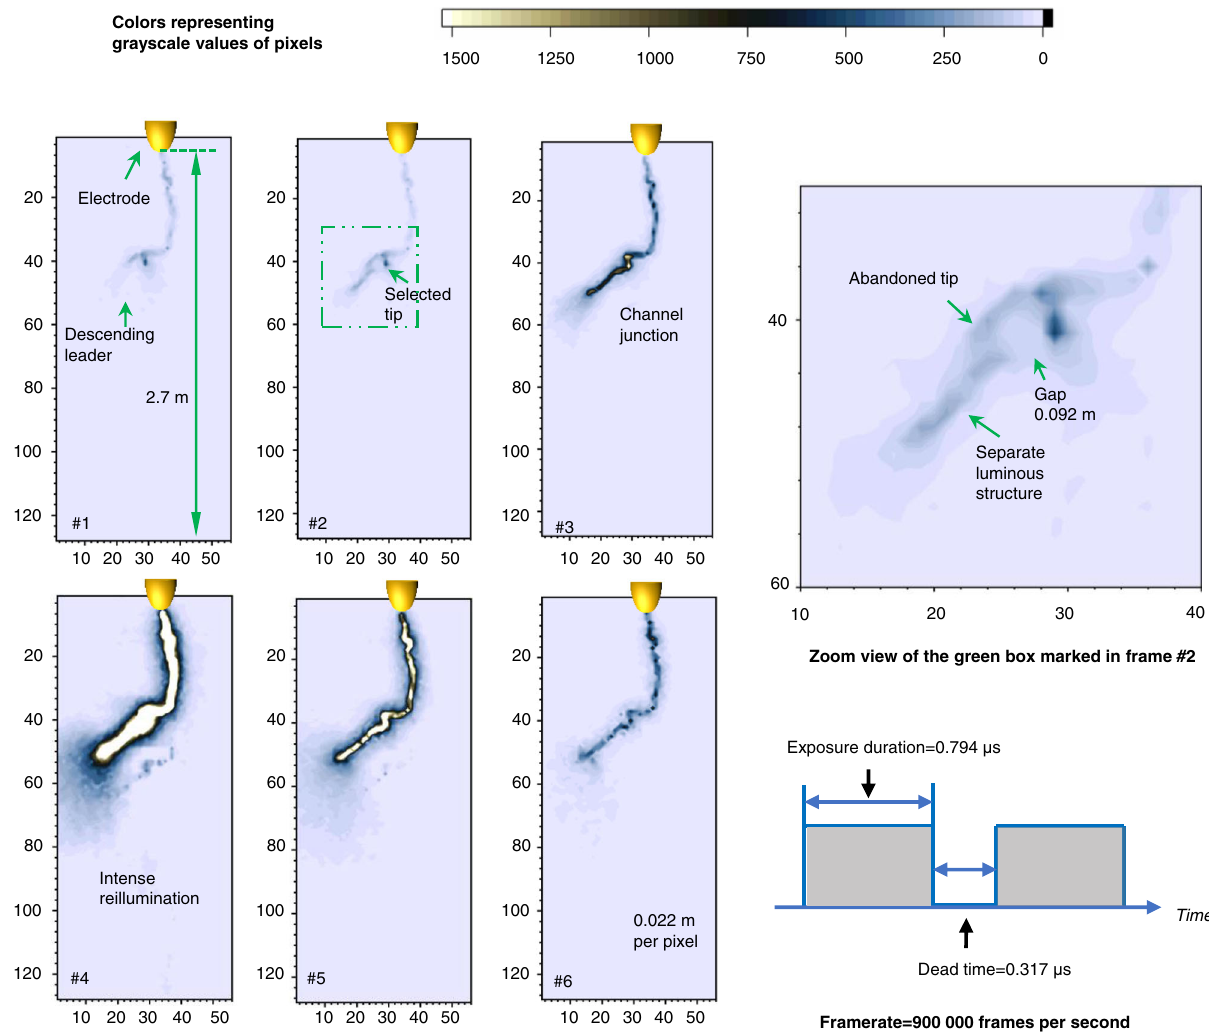
Fig. 1 Frames recording a positive leader step led by a separate luminous structure. The original high-speed video frames recording the positive leader step are grayscale images with 12-bit pixel depth, photography by a Photron FASTCAM SA-Z high-speed camera. A Canon TV-16 lens (25 mm 1:0.78) was used. The framerate was set as 900,000 frames per second. The resolution of these frames is 56 (in width) × 128 (in height) pixels. The fi eld of view covered a part of the air gap (2.7 m). To enhance visibility, these frames were pseudo-colored and shown in the fi gure. The color of pixels in these frames represents the value in the grayscale matrix extracted from the original frames. Pixels with grayscale exceeding 1500 are displayed in white. The coordinate marked in these frames represents the row and column numbers of the grayscale matrix. The 2.7-m long gap occupies 123 rows in the grayscale rows, indicating the spatial resolution of these frames is about 0.022 m per pixel. During the experiment, the relative humidity is 78 ± 2%, the temperature is 301 ± 0.21 K, the air pressure is 1 atm, and the calculated absolute humidity is 21.20 ± 0.3 g/m 3